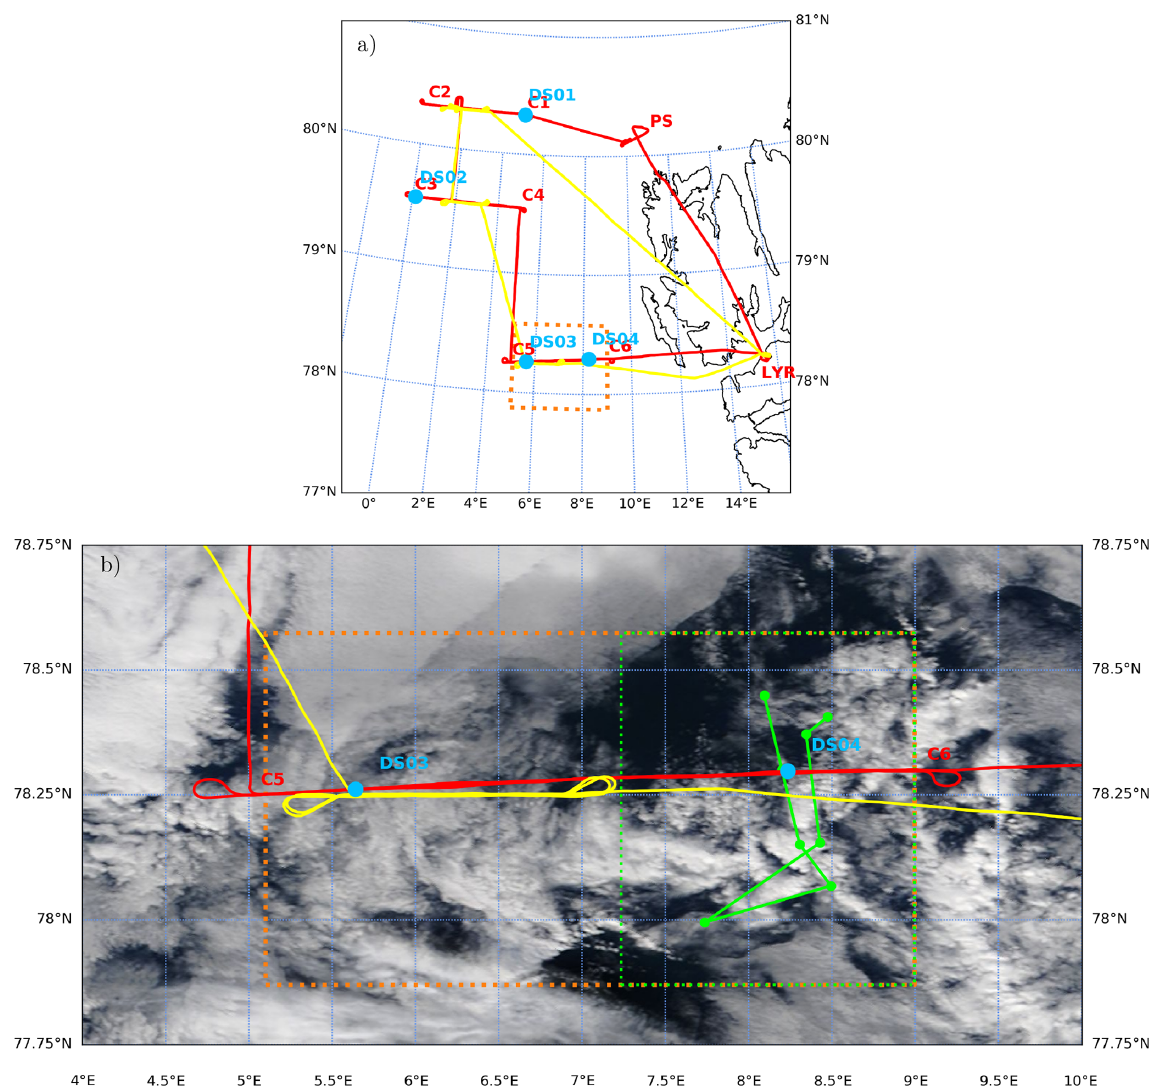
Figure 1. (a) The location of the RF20 mission over Fram Strait west of Svalbard (b) with a close-up of the target area: MODIS TERRA true- color image at 250m effective resolution during RF20 on 18 June 2017. The flight tracks of Polar 5 and Polar 6 are shown in red and yellow, respectively. For P5 the waypoints (C), RV Polarstern (PS) and Longyearbyen airport (LYR) are also indicated, with the dropsonde (DS) locations shown as blue dots. The 24h air mass trajectory intersecting with DS04 is shown as a solid green line. The target domain including the southern racetrack section is indicated by the dotted orange box, of which the simulated part is indicated by the dotted green box. MODIS data obtained through NASA Worldview (https://worldview.earthdata.nasa.gov/, last access: 22 July